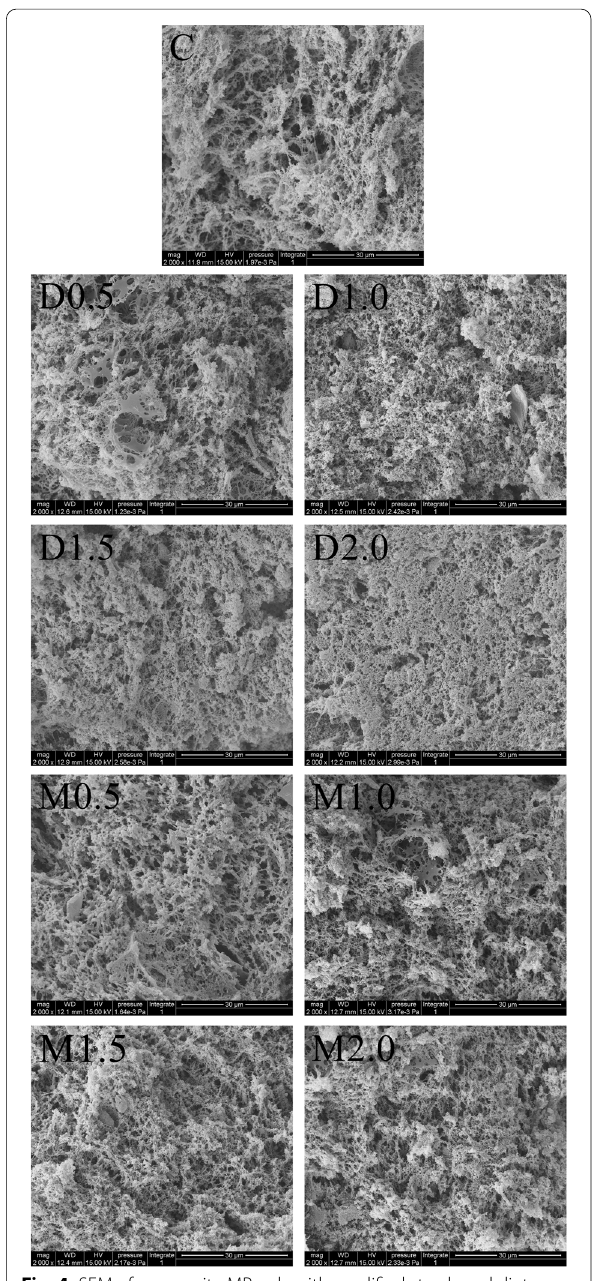
Fig. 4 SEM of composite MP gels with modified starch and dietary fiber. C: The control; D0.5: MP with 0.5% modified starch; D1.0: MP with 1.0% modified starch; D1.5: MP with 1.5% modified starch; D2.0: MP with 2.0% modified starch; M0.5: MP with 0.5% dietary fiber;